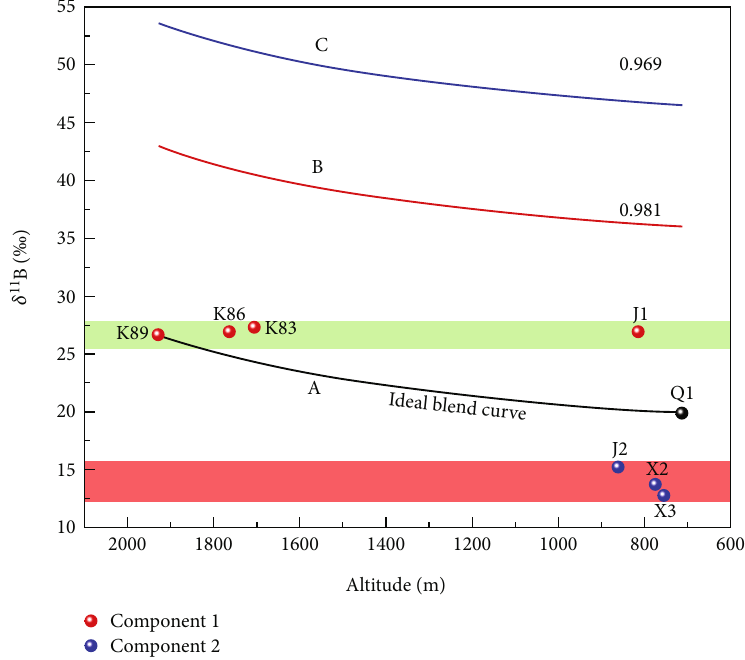
Figure 5: Relationship between the δ 11 B values of the water samples and the altitude of the Kumish basin. The green and red areas in the fi gure indicate the boron isotopic composition ranges of component 1 and component 2, respectively.